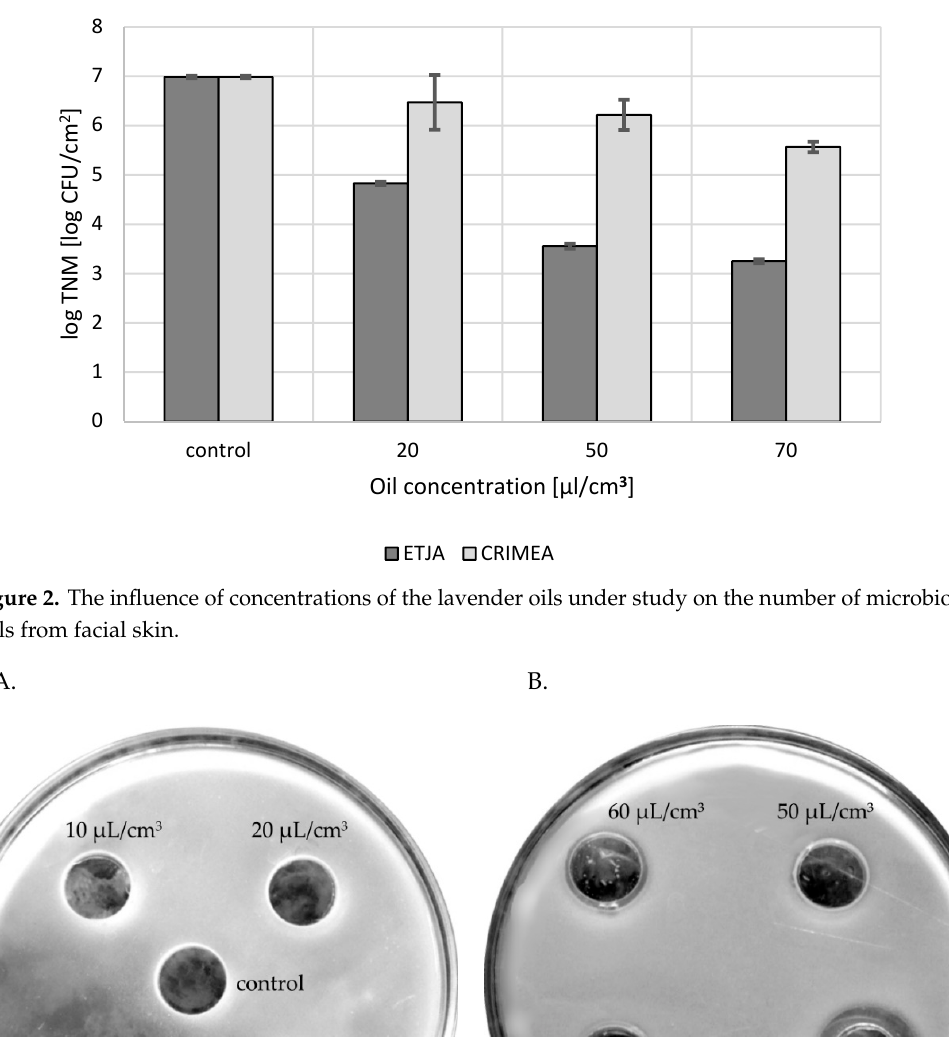
Table 5. Zones of growth inhibition of dominant bacterial isolates.